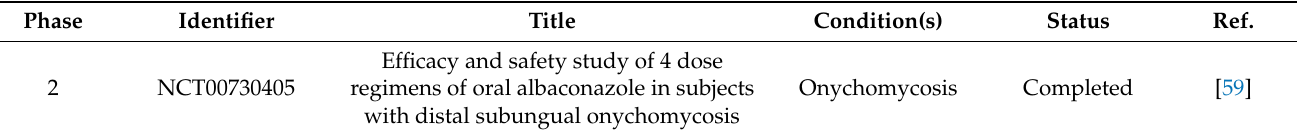
Figure 10. Chemical structure of albaconazole ( 8 ) [5] . Table 4. Clinical trials for albaconazole ( 8 ) (summarized). Table 4. Clinical trials for albaconazole ( 8 )